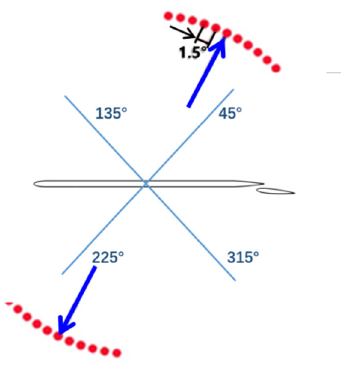
Figure 7. Microphone array for far-field measurements.